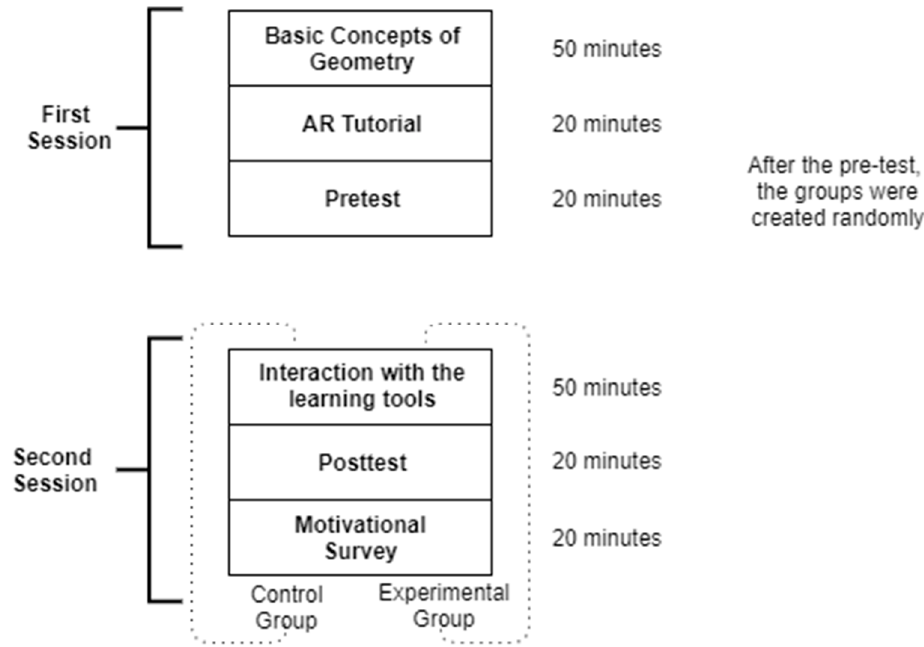
Figure 5. Steps of the intervention.